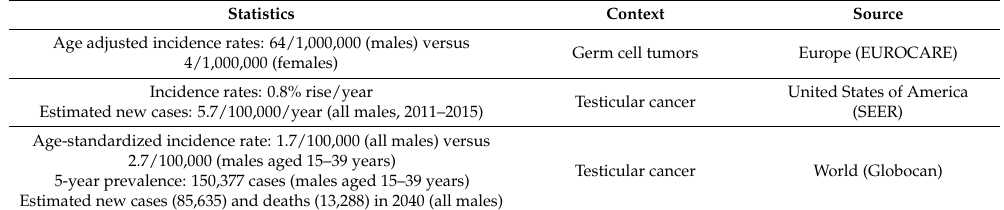
Table 1. Epidemiology of germ cell tumors: incidence, prevalence, and mortality